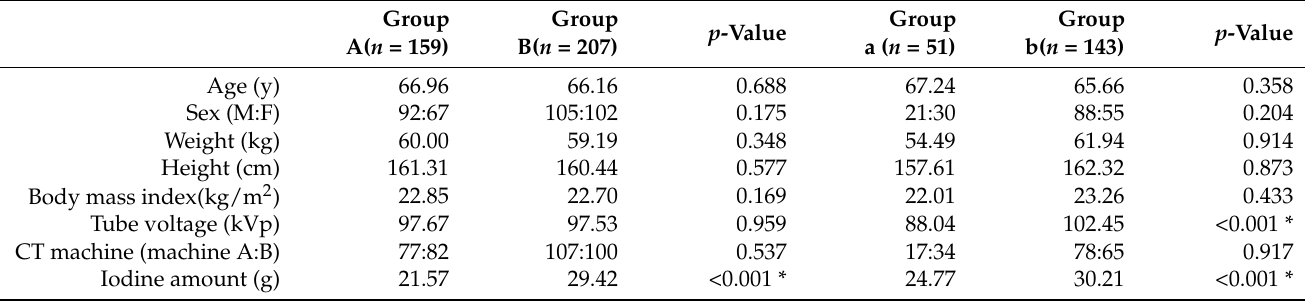
Table 2. Mean value of patient